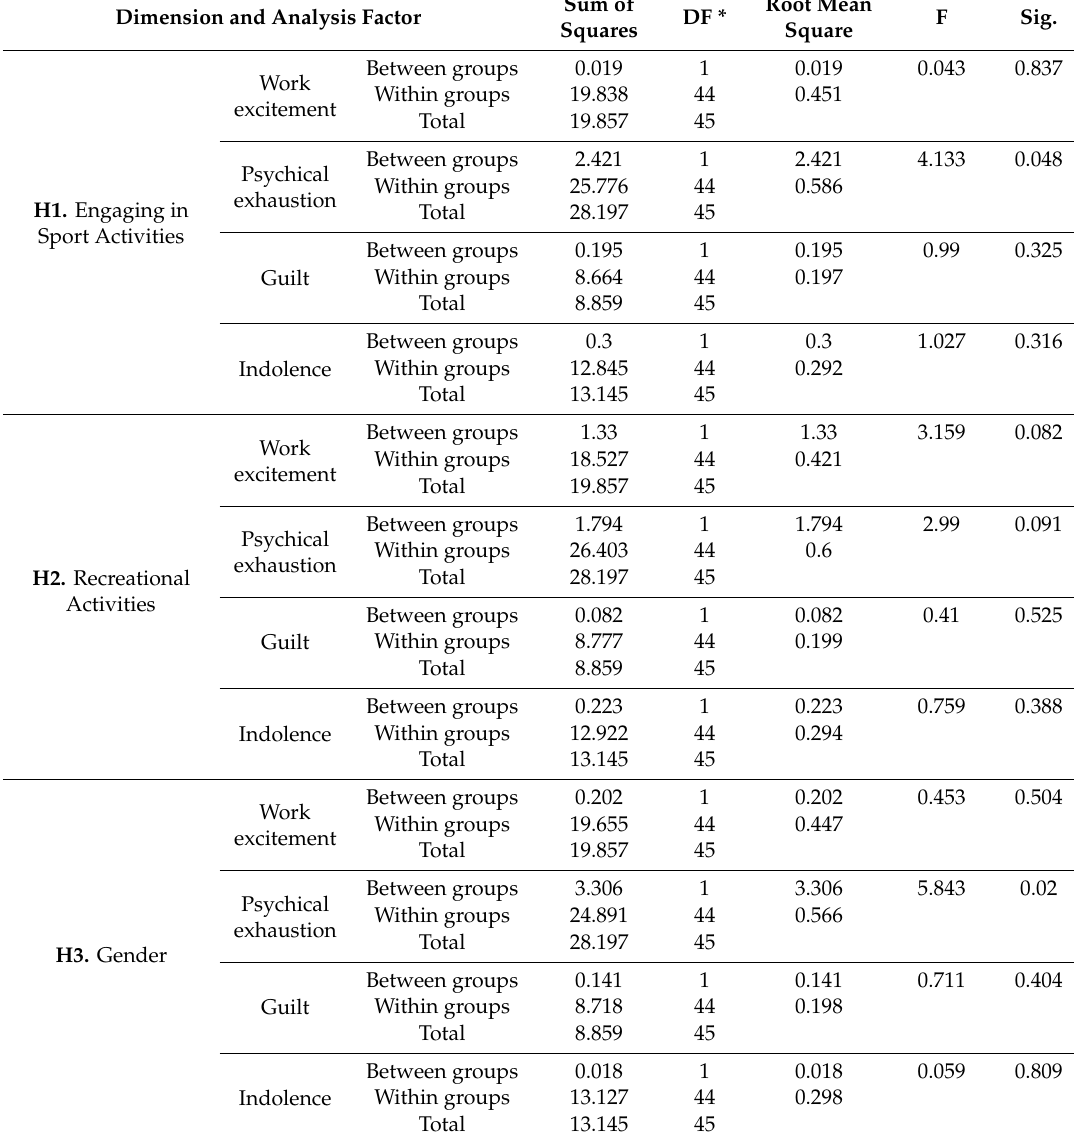
Table 4. Analysis of variance (ANOVA) for the CESQT’s dimensions between the development of recreational activities, demographic conditions, and working conditions.